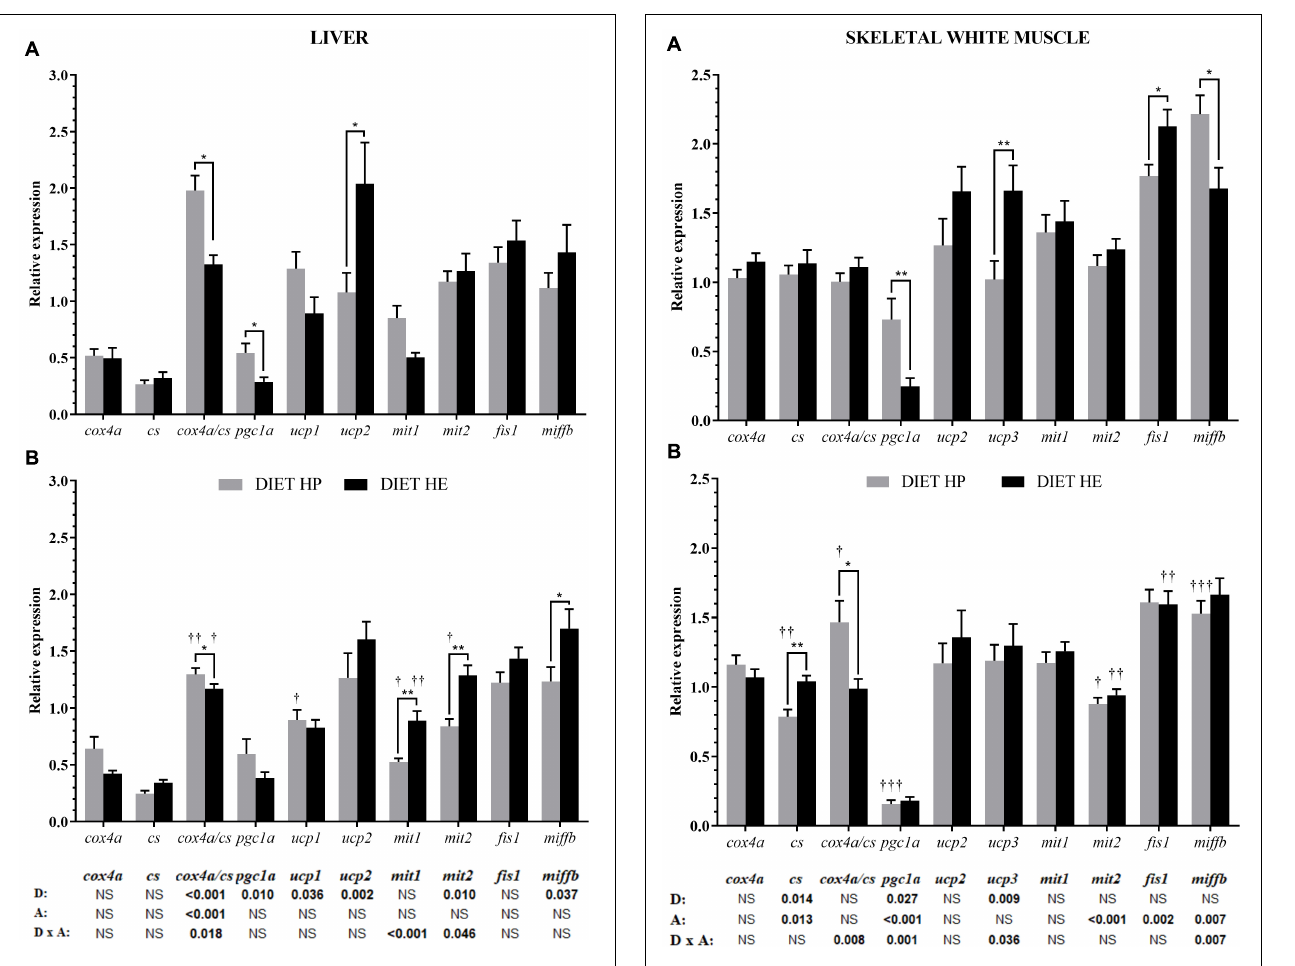
FIGURE 2 | Relative gene expression of the enzymes in energy metabolism, markers of mitochondrial biogenesis, and markers of mitochondrial dynamics in the white skeletal muscle of gilthead seabream fed the HP or HE diet under conditions of voluntary swimming (A) or sustained swimming (B) . Data are shown as the mean ± SEM ( n = 12 for VS and n = 16 for SS conditions). The factorial statistical analysis was assessed by two-way ANOVA and the p -values of the diet (D), swimming activity (A) and the interaction (D × A) are displayed at the bottom of the figure. Pairwise comparisons were assessed by unpaired Student’s t -test. ∗ p < 0.05 and ∗∗ p < 0.01 between diet groups (HP and HE); † p < 0.05, †† p < 0.01, and ††† p < 0.001 between swimming activity groups (VS and